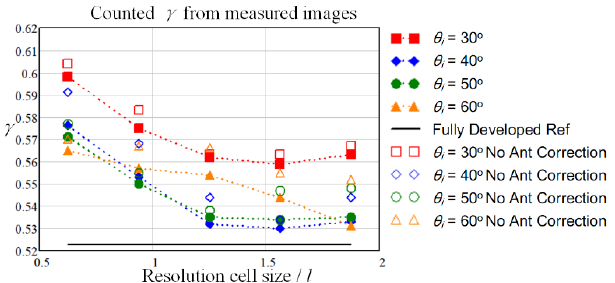
Figure 10. The normalized amplitude PDF curves of measured images at different θ i , at the resolution cell size of 60 mm, VV, compared with Rayleigh distribution and K ‐ distribution. (Sample parameters are shown in Table 1). Table 4. Comparisons of the average intensity values and amplitude speckle values from the measured images at the resolution cell size of 30 mm and 60 mm. (Sample parameters shown in Table 1).